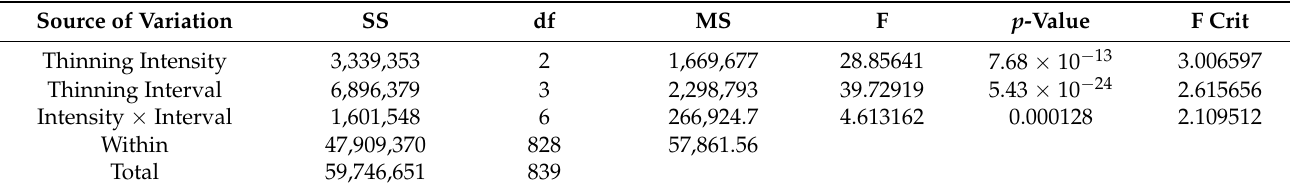
Table A8. Two-way ANOVA test for water